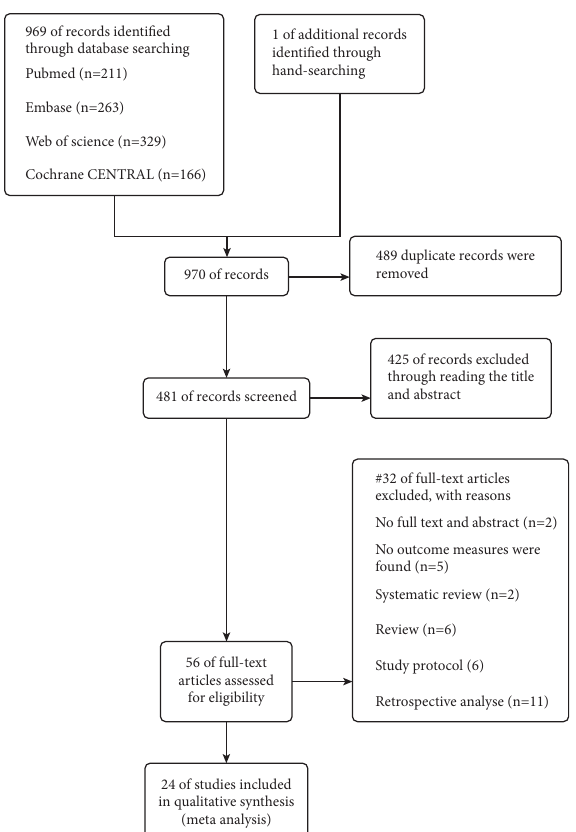
Figure 1: Te selection fow